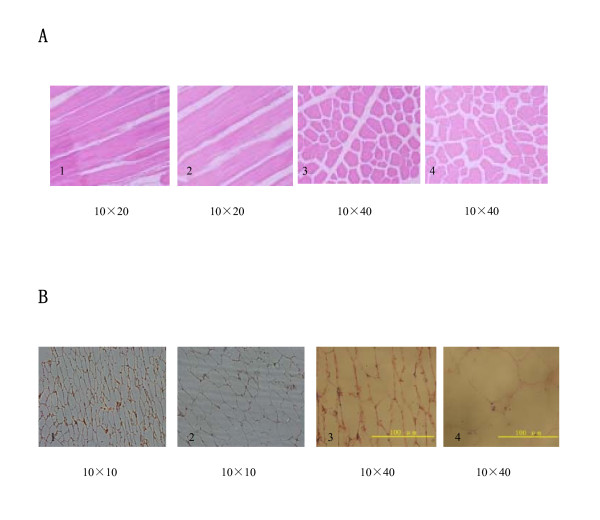
1A. Skeleton muscle (biceps femoris) histological section of pigs with/without the administration of clenbuterol. 1. transverse, test pigs. 2. transverse, control pigs. 3. longitudinal, test pigs. 4. longitudinal, control pigs. Vertical fiber sections analyzed with TD2000 real-color pathology image analysis system (Beijing Tiandibainian Scientific Company Ltd.). The muscle fibers of pigs become thicker when treated with clenbuterol. 1B. Subcutaneous back fat (at the fifth lumbar vertebra level) histological section of pigs with/without the administration of clenbuterol. 1. amplified10 × 10 of test pigs. 2. amplified 10 × 10 of control pigs. 3. amplified 10 × 40 of test pigs. 4. amplified 10 × 40 of control pigs. The sizes of the pig adipose cells decreased when treated with clenbuterol. The cell size was analyzed by counting cells on the slide visible through the microscope eyepiece.